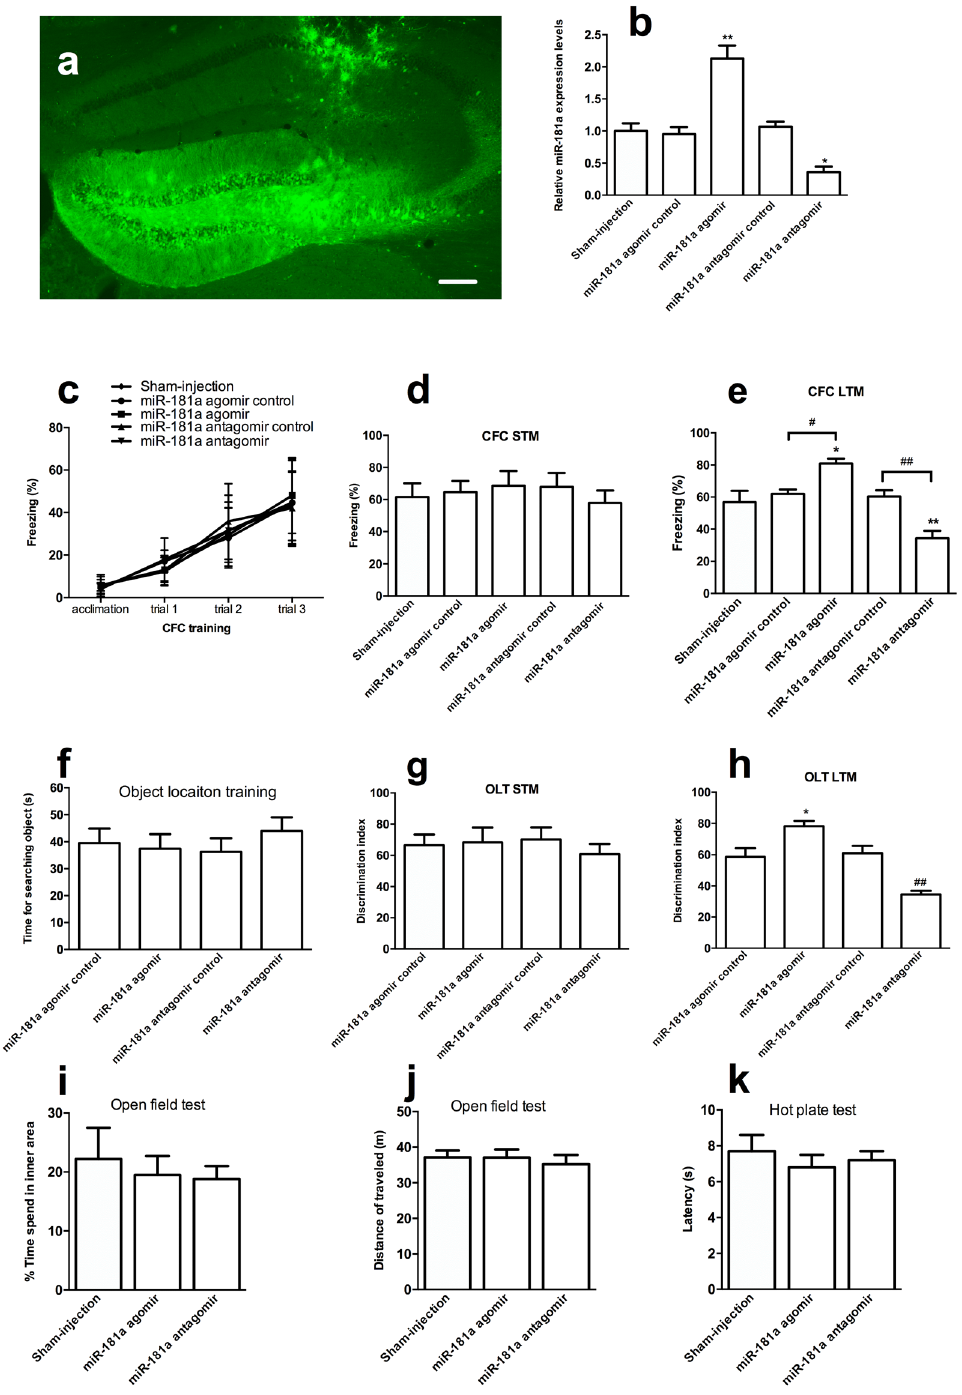
Figure 2. miR-181a was involved in LTM formation following CFC and OLT. ( a ) Representative image showing the location and extent of diffusion of the miR-181a antagomir in the DH. Scale bar, 200 μ m. ( b ) Relative levels of miR-181a in the DH after miR-181a agomir or antagomir injection. * p < 0.05, ** p < 0.01, compared with the Sham-injected group. n = 5 per group. ( c ) Freezing response during the CFC training. The freezing percentages in the acclimated period (120 s) and each post-shock intervals (60 s per trial) were recorded. ( d–e ) Freezing response 1 h ( d ) and 24 h (e) after CFC training. * p < 0.05, ** p < 0.01, compared with the Sham-injected group. # p < 0.05, ## p < 0.01, compared with the agomir or antagomir control group, respectively. n = 7 per group ( d ). n = 10 per group ( e ). ( f ) Time spent for searching objects during OLT training. ( g–h ) Discrimination index 10 min ( g ) and 24 h ( h ) after OLT training. * p < 0.05, compared with the miR-181a agomir control group. ## p < 0.05 compared with the miR-181a antagomir control group. n = 7 per group ( g ). n = 10 per group ( h ). ( i–j ) Time spent in the inner area ( i ) and total distance traveled in the open field test ( j ). ( k ) Latency in the hot plate test. n = 8 per group. All values are presented as means ±